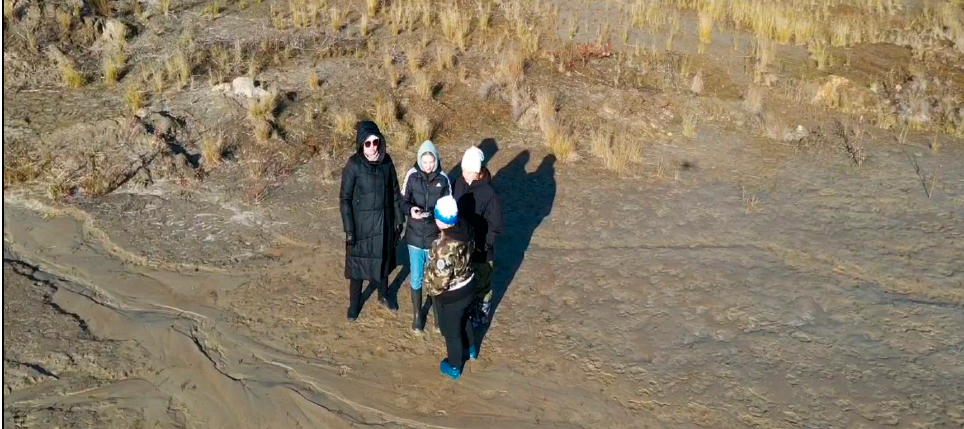
Figure 4. Drones are used to describe landscapes.